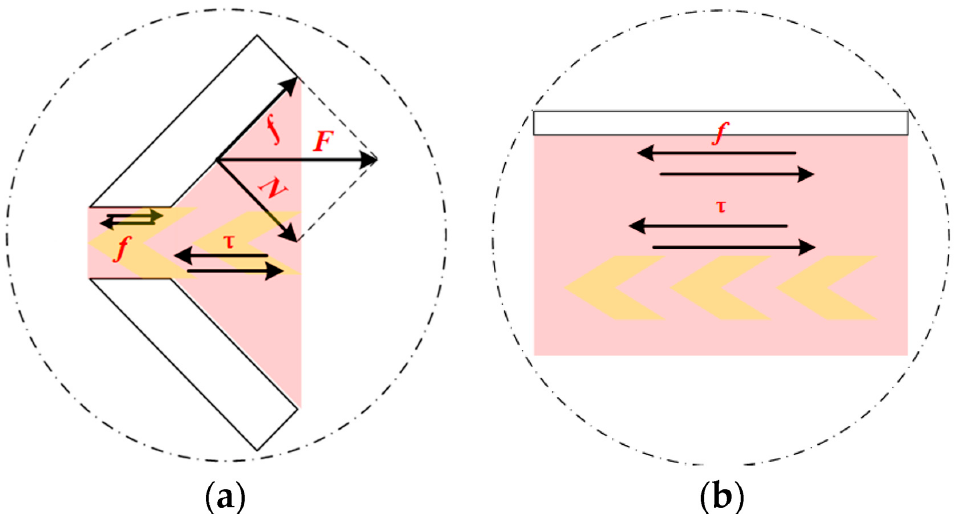
Figure 5. Pumping and extrusion process: ( a ) the friction of material between the pipe and nozzle, ( b ) the internal extended shear yield stress. Where f (N) is friction between the material and the inner wall, τ (N) means shear stress of the material, N (N) demonstrates the stress given from instrument inner wall during the extrusion process, F (N) notes resultant of N and